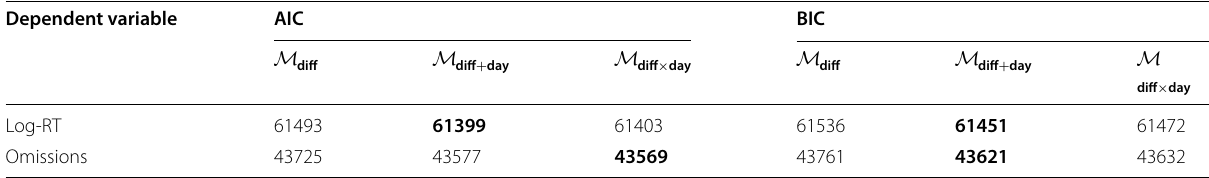
Table 3 Results of model comparison for effect of testing day and difficulty on DRT performance Dependent variable AIC